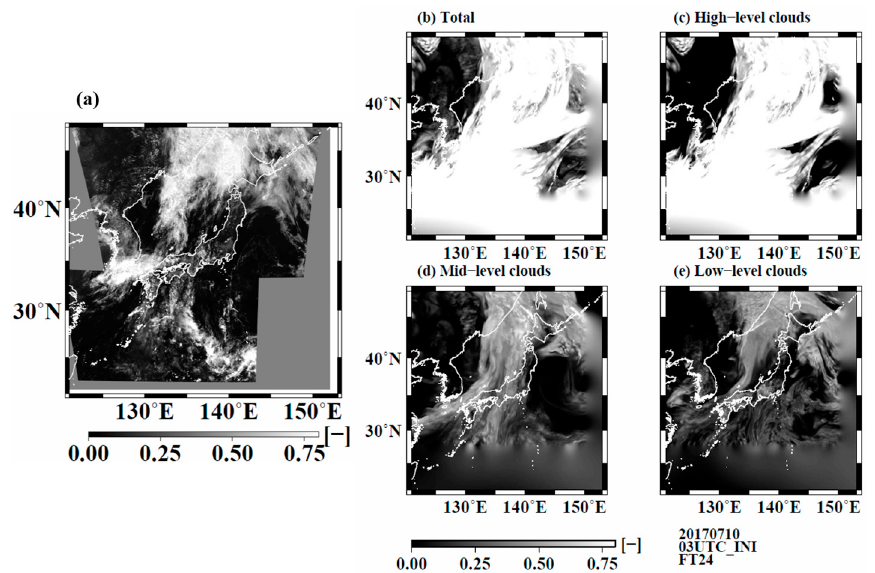
Figure 17. Same as Figure14, but for on 11 July 2017.